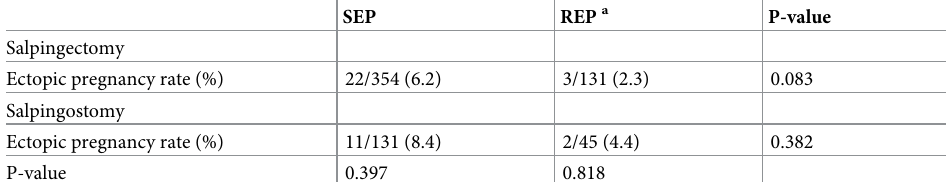
Table 4. Effect of previous ectopic pregnancy treatments on the incidence of ectopic pregnancy after IVF/ICSI. SEP REP a P-value Salpingectomy Ectopic pregnancy rate (%) 22/354 (6.2) 3/131 (2.3) 0.083 Salpingostomy Ectopic pregnancy rate (%) 11/131 (8.4) 2/45 (4.4) 0.382 P-value 0.397 0.818 Note : Values as number (%). a Seventy-six patients with clinical pregnancy were excluded because they had experienced both salpingectomy and salpingostomy treatments in their multiple EP conditions. Abbreviations: SEP, single ectopic pregnancy; REP, recurrent ectopic pregnancy; IVF, in vitro fertilization; ICSI, intracytoplasmic sperm